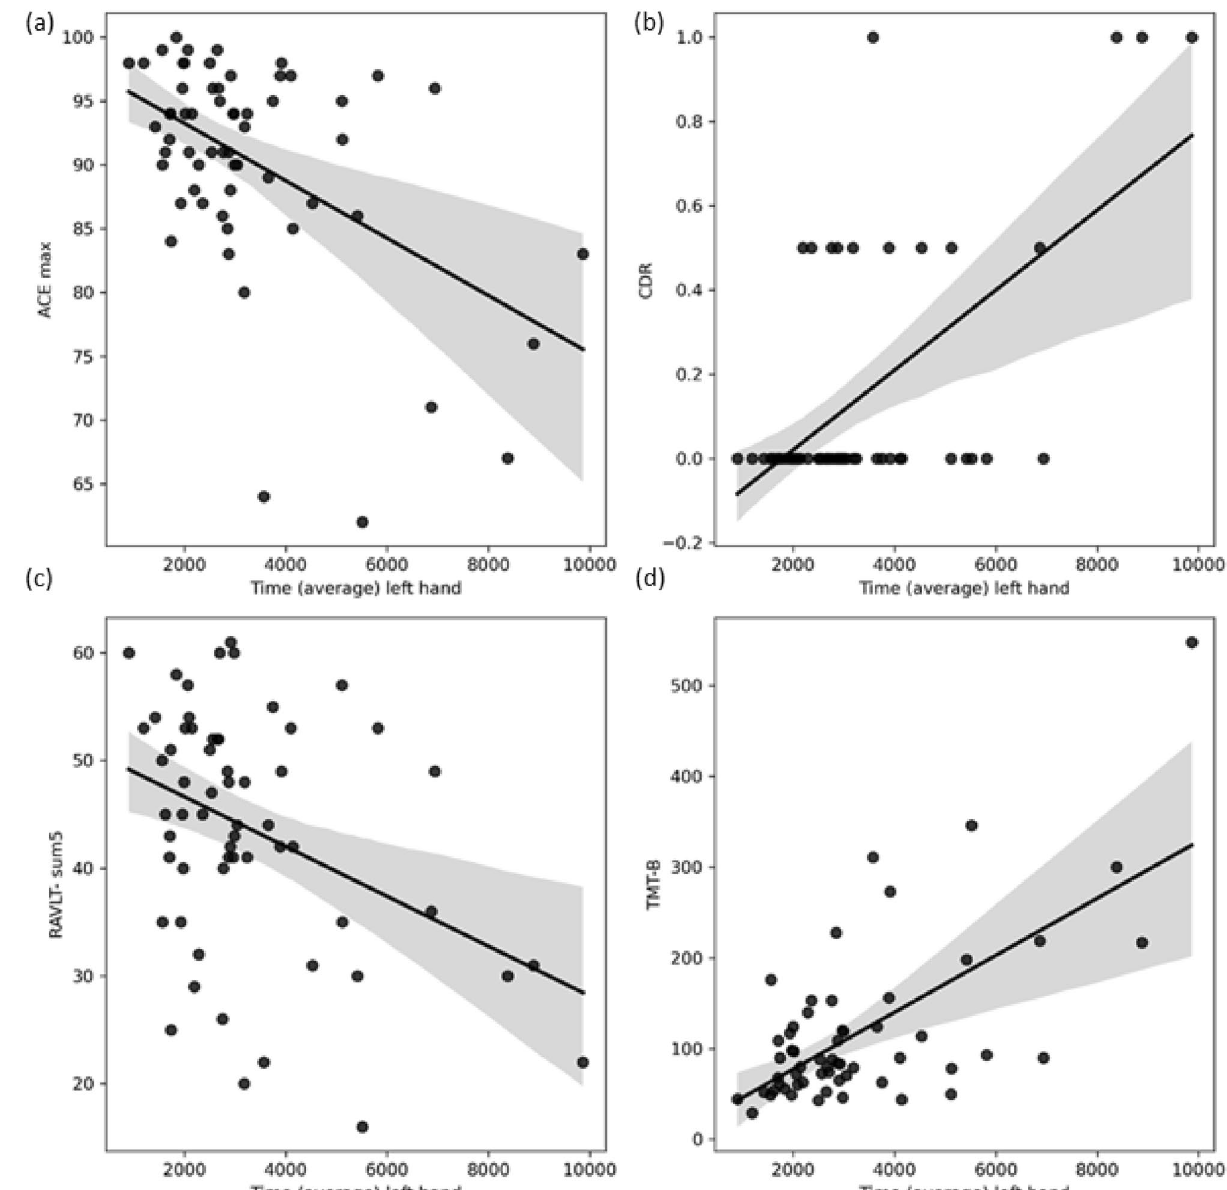
Figure 3. Scatter dots of correlation analysis across time average of left-hand movements (in ms) and neuropsychological test results. Where worse cognitive performance is characterized by lower cognitive scores (Addenbrooke Cognitive Examination (ACE) ranging between 0 and 100 and Rey Auditory Verbal Learning (RAVLT) summary of first 5 trials ranging between 0 and 75), negative correlation is presented with the time required for mouse movements. However, where worse cognitive performance associates with higher neuropsychological scores (Clinical Dementia Rating Scale (CDR) ranging between 0 and 3 and Trail-Making Test B (TMT-B) measured in required seconds), positive correlation is found. ACE Addenbrooke Cognitive Examination, RAVLT Sum-5 Rey Auditory Verbal Learning Test Summary of first 5 trials. TMT-B Trail-Making Test B, CDR Clinical Dementia Rating